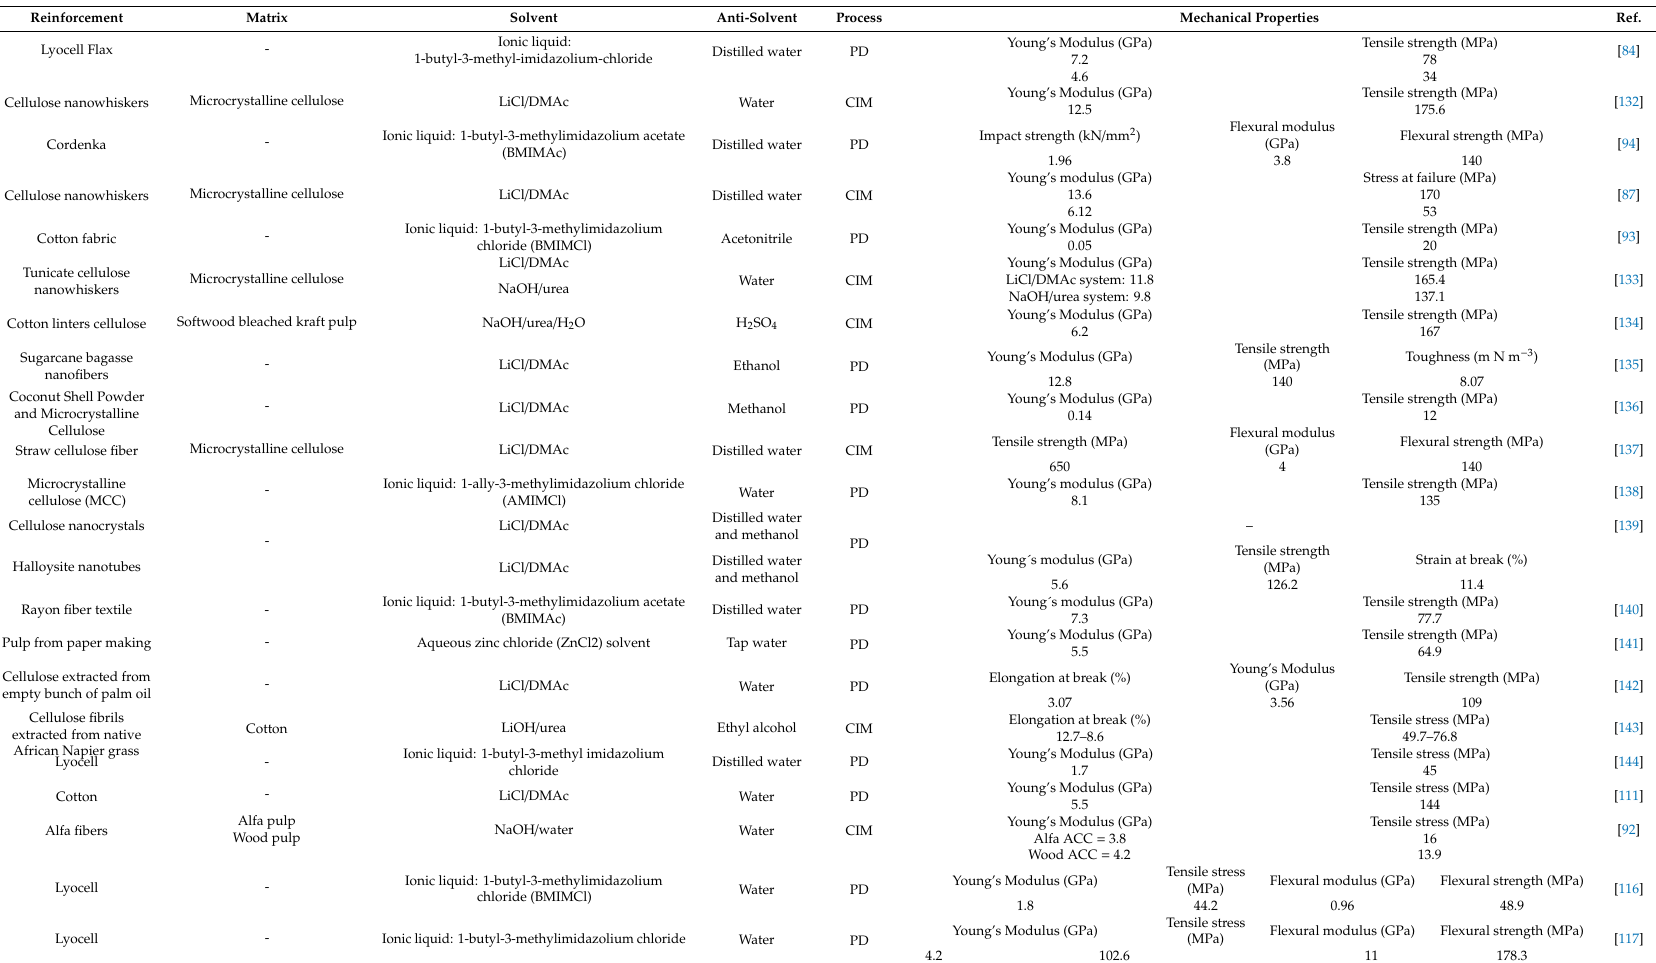
Lyocell - Ionicliquid: 1-butyl-3-methylimidazoliumchloride